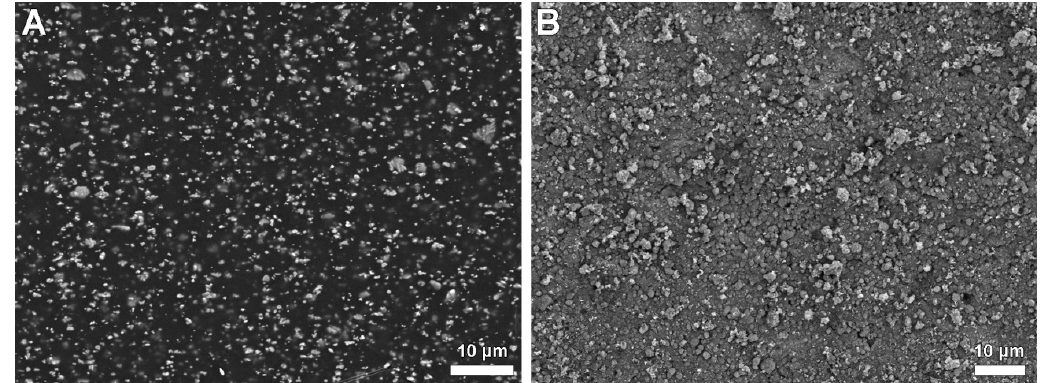
Figure 16. SEM of implants for urinary bladder rat before implantation. ( A ) group A, Elastollan + barium sulphate. ( B ) group B, Elastollan + barium sulphate + a-C:H/Cu-mulitilayer coating. FE-SEM Merlin VP compact (Zeiss, Germany), magnification ( A ): 1.4 × 10 3 , bar 10 µm, ( B ): 1.12 × 10 3 , bar 10 µm.